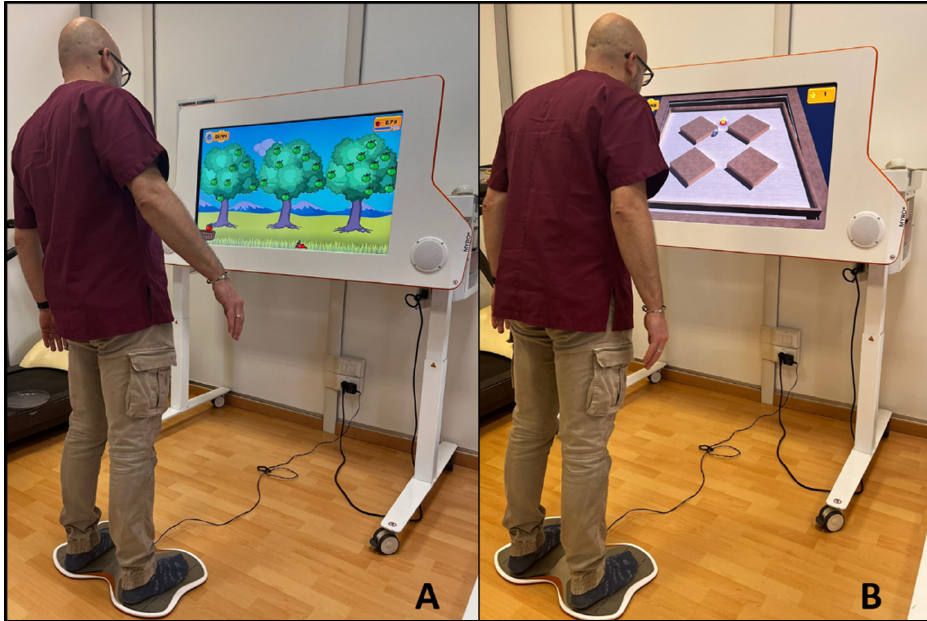
Figure 2. Examples of interaction between subject and the Tymo ® system . ( A ): Non-immersive virtual exergame 'apple picking’; ( B ): non-immersive virtual exergame ‘the labyrinth’.